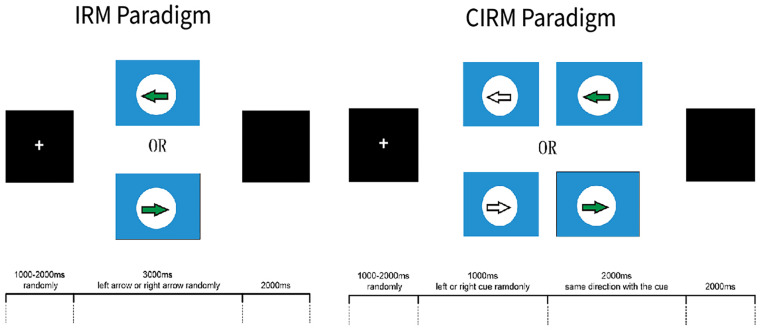
E-Prime ERP experiment paradigms. This figure adapted from Li et al. (2018).